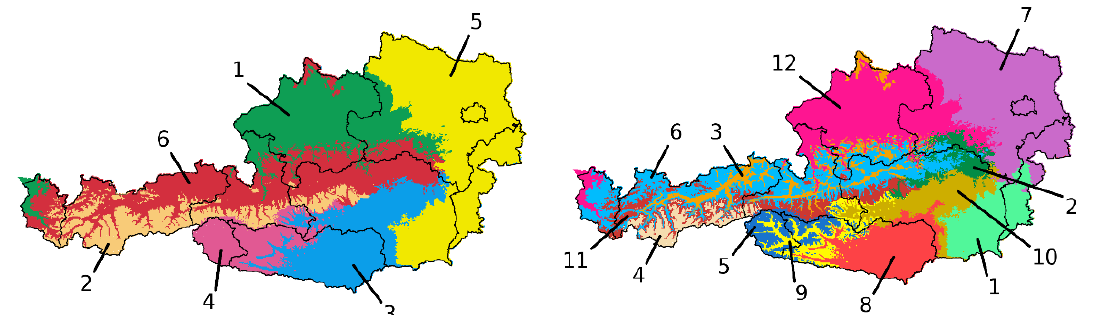
Figure 9. Results of the agglomerative hierarchical cluster analysis for 6 ( left ) and 12 ( right ) clusters based on the modelled seasonal (NDJFMA) snow depth HS. The underlying 1 km × 1 km data matrix covers the seasons from 1961/62 to 2019/20.